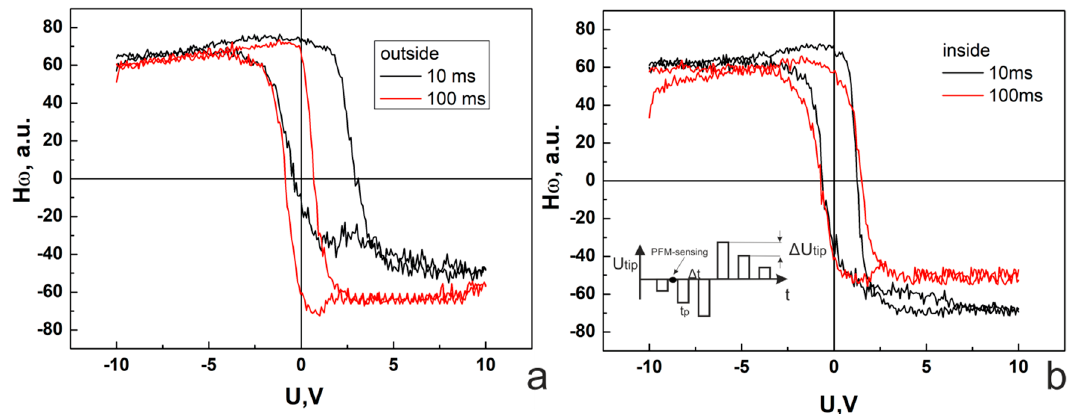
Figure 4. The diameter ( a ) and length ( b ) of domains, written on the polar and nonpolar surfaces, respectively, of zero-field cooled (ZFC) SBN crystals vs. exposure time and dose.In Figure 4b the dashed line shows the linear approximation; the results were obtained at U = 25 kV.